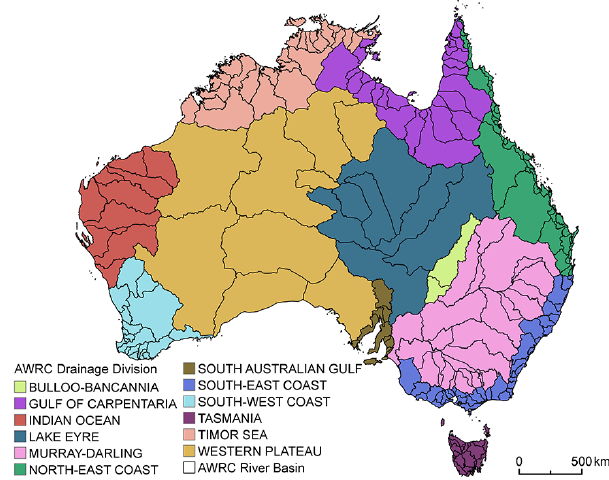
Figure 1. Australian Water Resource Council (AWRC) Drainage Divisions and River